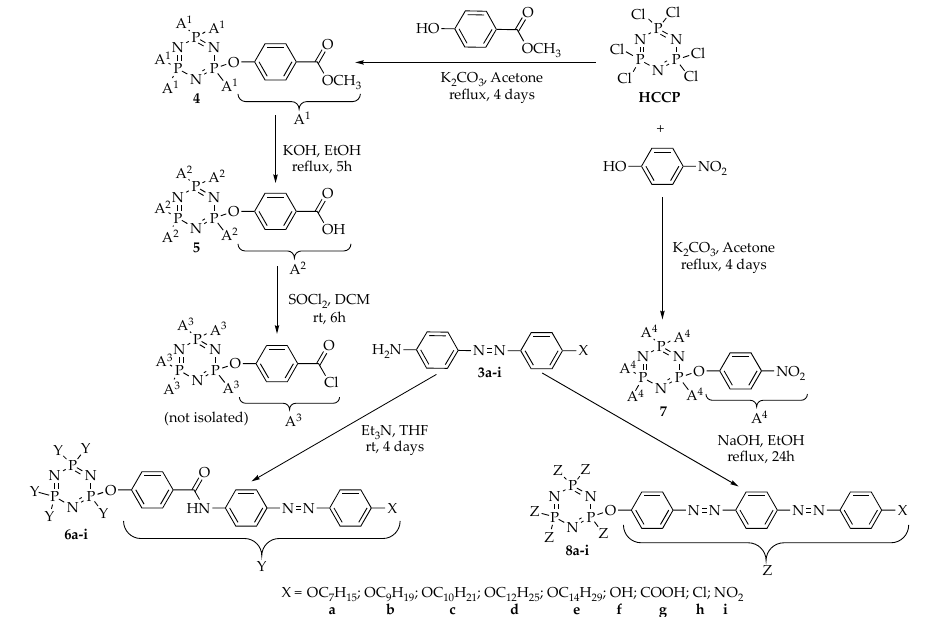
Scheme 2. Formation of disk-like intermediates ( 4 , 5 , and 7 ) [37,38] and hexasubstituted cyclotriphosphazene compounds ( 6a–i and 8a–i ) [35,39].